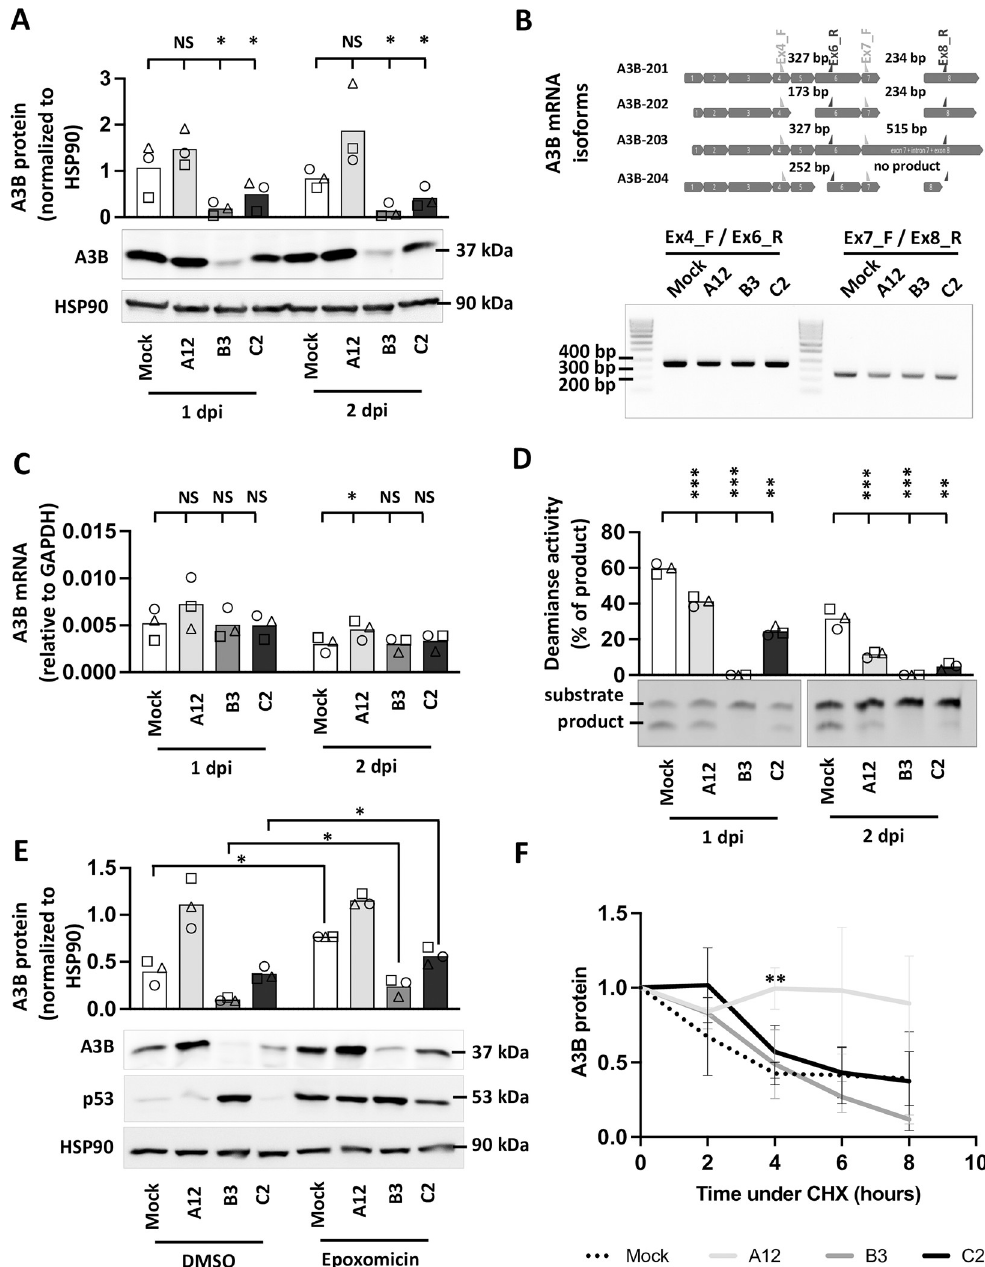
Fig 7. Adenovirus infection reduces A3B quantity and/or enzymatic activity depending on the viral strain. A549 cells were infected with HAdV-A12, -B3, -C2 or mock control at a MOI = 3. (A) A3B protein levels were assessed by western blot at 1- and 2-days post infection, quantified by densitometry and normalized with HSP90. (B) A3B mRNA isoforms were detected by discriminative RT-PCR reactions at 2-days post infection. (C) A3B mRNA levels were quantified by RTqPCR at 1- and 2-days post infection and expressed relative to GAPDH mRNA. (D) Deamination activities of the cell lysates were expressed as the percentage of substrate converted into product and compared to the deamination activities of the mock-infected cells at 1- and 2-days post infection. P-values were calculated by ratio t-tests. (E) Epoxomicin was added at 16 hpi. Six hours later, A3B, p53 and HPS90 protein levels were assessed by western blot. P-values were calculated by paired t-tests. (F) Cycloheximide was added at 16 hpi. The levels of A3B, p53 and HPS90 proteins were evaluated by western blot for a period of 8 hours and expressed relative to the level measured just before the addition of cycloheximide. P-values were calculated by t-tests (infected conditions compared to mock). Error bars show standard deviation.